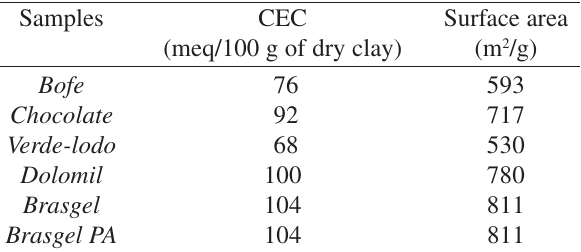
Table 2. Cation exchange capacity (CEC) and surface area deter- mined by the method of methylene blue adsorption.